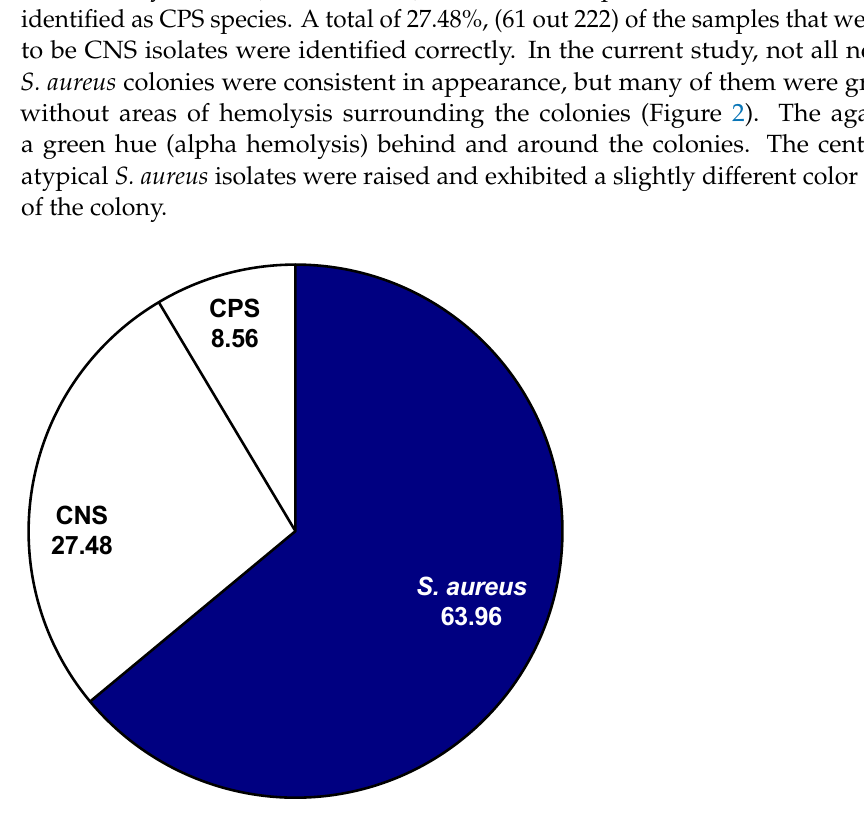
Figure 1. Identification of isolates (%) presumed to be coagulase-negative staphylococci (CNS) species.